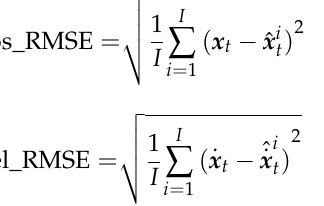
Figure 9. Localization error versus the satellite number. Figure 10 shows the change curve of the vel_RMSE with the number of satellites. It can be seen from the figure that the velocity estimation error of the system was within 1m/s. When the number of satellites of the system reached more than five, the vel_RMSE